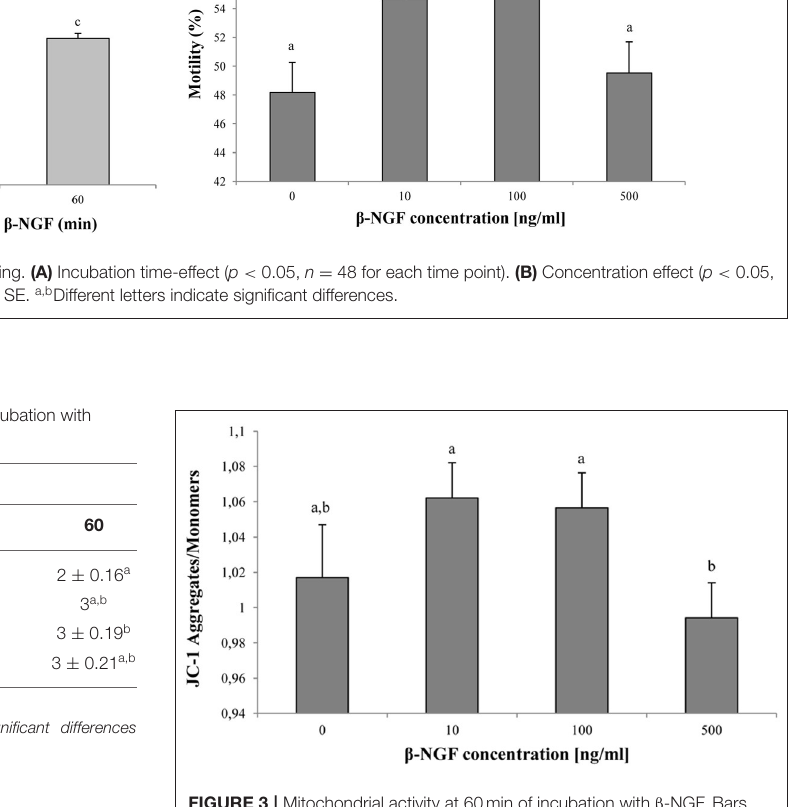
FIGURE 3 | Mitochondrial activity at 60min of incubation with β -NGF. Bars represent the mean of JC-1 aggregate/monomer ratio ± SE, n = 12 for each treatment. a,b Different letters indicate significant differences ( p <